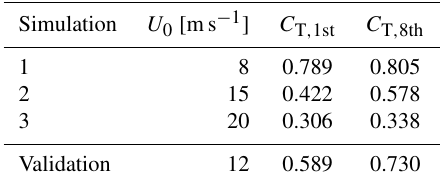
Table 1. Summary of inflow parameters for wind farm simulations and operational conditions of the wake-generating first and eighth wind